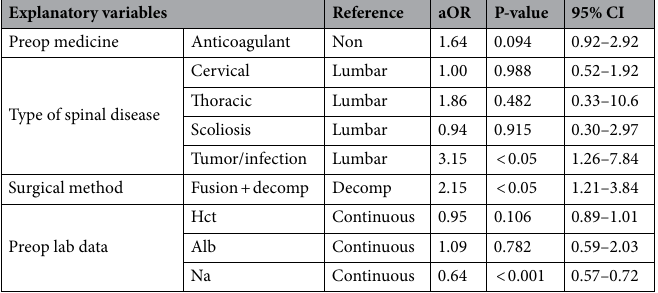
Table 4. Multivariate analysis for the risk factors of postoperative hyponatremia. Alb albumin, aOR adjusted odds ratio, CI confidence interval, Decomp decompression, Hct hematocrit, Na sodium, Preop preoperative.